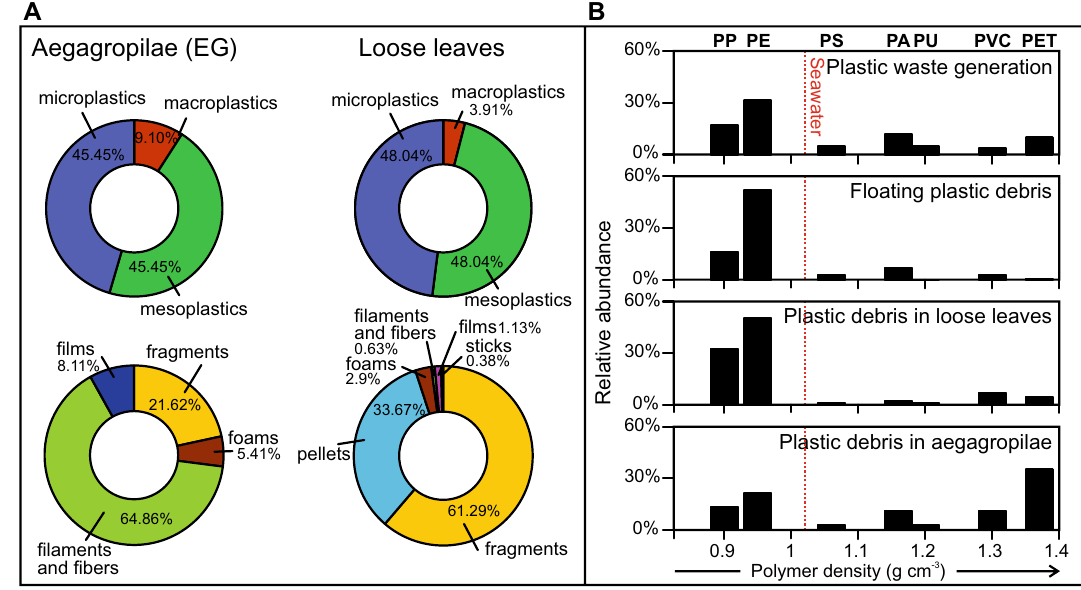
Figure 1. Plastic debris in seagrass remains. ( A ) Pie chart illustrating size of plastic debris (microplastics < 5 mm, mesoplastics 5–25 mm, and macroplastics > 25 mm), and type of plastic (filaments and fibers, fragments, films, foams, pellets and sticks) found in beached aegagropilae (EG) and loose leaves (wracks). ( B ) Relative abundance of each plastic polymer in plastic waste generation, floating plastic debris, plastic